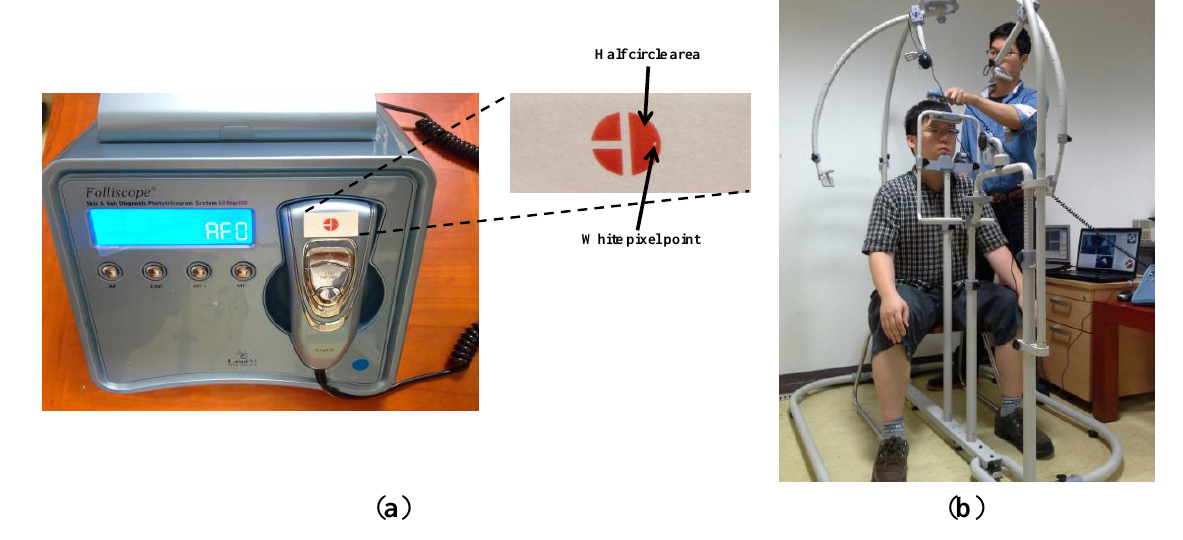
Figure 5. Commercial diagnostic device for scalp skin diagnosis and its use. ( a ) Commercial diagnostic device with attached color marker; ( b ) Example of using the